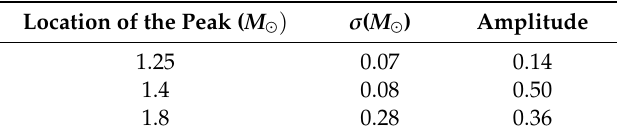
Table 1. The distribution of measured NS masses obtained from the analysis of the sample in [16] within a Gaussian parametrization normalized to the total number of